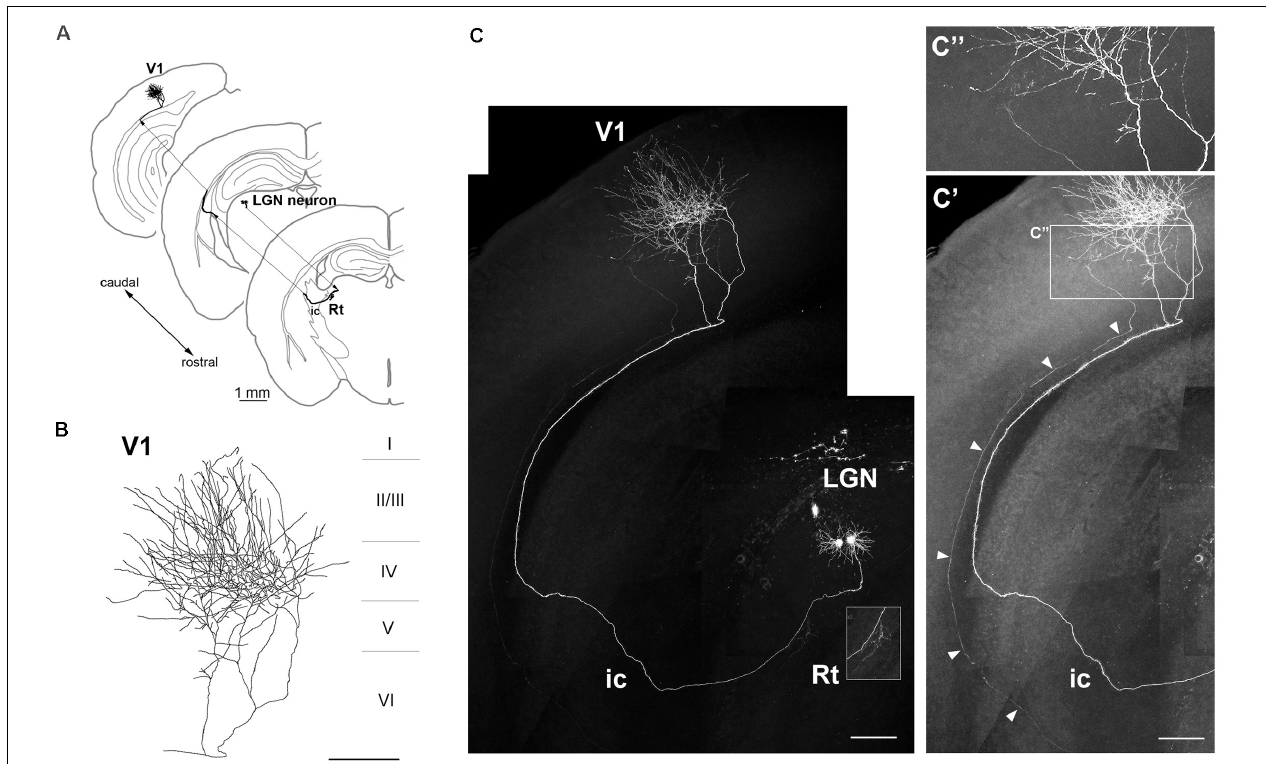
FIGURE 4 | Axonal projection of an LGN neuron. (A–C) Axonal projection of an LGN neuron to V1 and thalamic Rt (inset in C ). The neuron had a dense axonal arbor in layer IV (B) . Another dim ascending axon (arrowheads) was observed from the internal capsule (ic) to V1 ( C’ , brightness adjustment view of panel C ), but in patches in layer IV of V1 ( C” , higher magnification view of areas indicated in panel C’ ). Scale bars, 1 mm for panel (A) ; 200 µ m for panels (B,C,C’) ; 100 µ m for panel (C”)